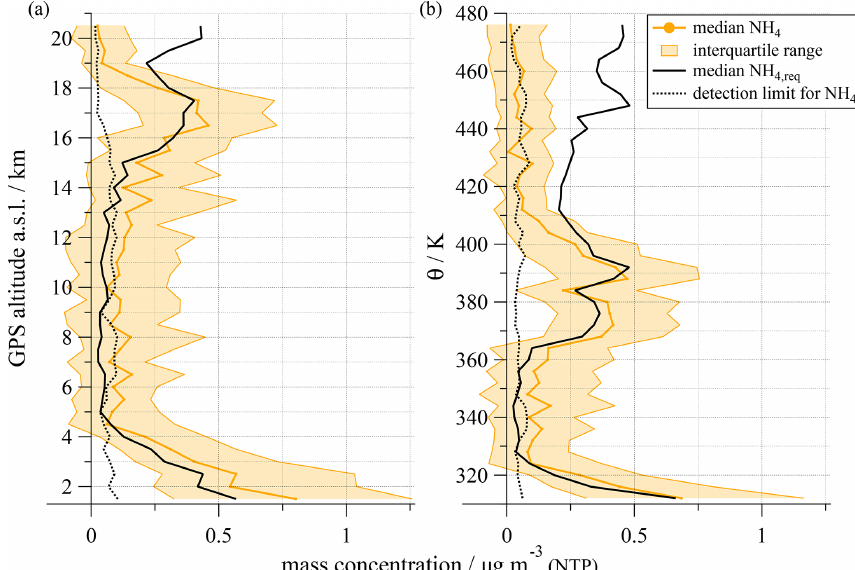
Figure 6. Vertical profile of the mass concentration of particulate ammonium (orange) with median and interquartile ranges measured by the ERICA-AMS as well as the median-calculated ammonium required for full neutralization of the inorganic components (NH 4 , req , black line) as a function of (a) GPS altitude and (b) potential temperature θ . The shaded areas delineate the 25th and 75th percentiles, and the detection limit of ammonium is shown as a dotted line.